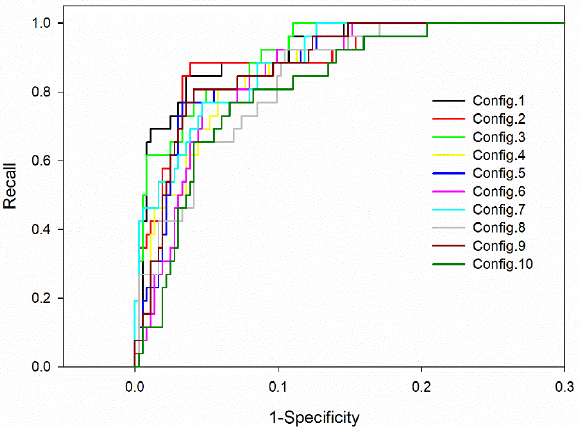
Figure 4. ROC curves for threshold ‐ based binary classification from regression ‐ estimated Ψ stem for all input configurations and T = 10 days. Table 8. AUC metrics for ROC curves obtained from binary classification applied using thresholds on the regression ‐ estimated Ψ stem .